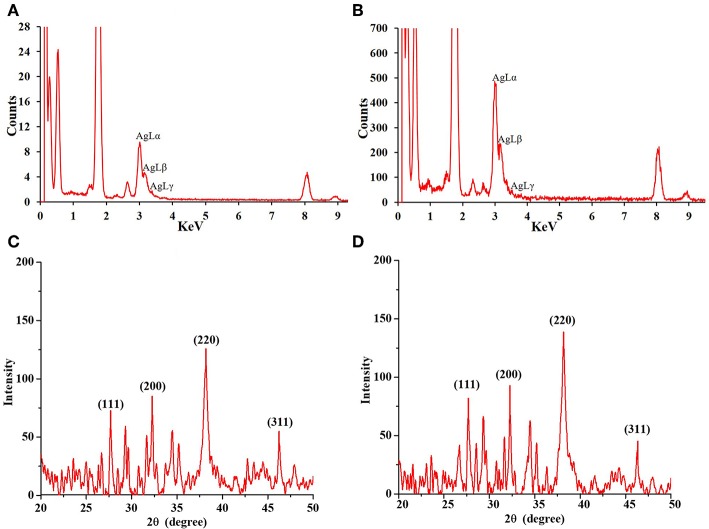
Energy dispersive X-ray (EDS) spectra of Aq-bAgNPs (A), and Et-bAgNPs (B). Peaks at ~3 keV indicate the presence of Ag in the biogenic nanoparticles. Powder XRD analysis of as-synthesized Aq-bAgNPs (C), and Et-bAgNPs (D).